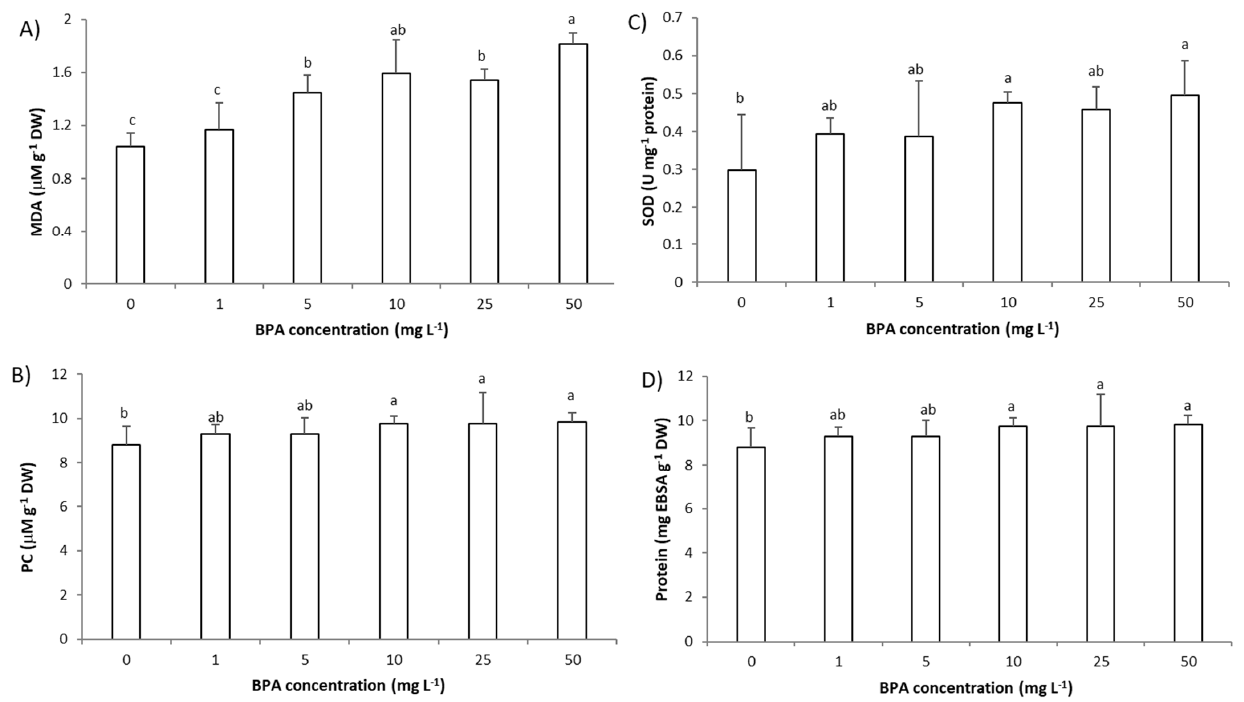
Figure 5. Oxidative stress parameters and level of proteins in Allium cepa root cells exposed to BPA (1–50 mg L − 1 ) for 3 days. Oxidative stress was monitored as level of: ( A ) malondialdehyde (MDA) as marker of lipid peroxidation, ( B ) protein carbonyls (PC) as marker of oxidative damage to proteins, ( C ) catalytical activity of antioxidative enzyme superoxide dismutase (SOD) and ( D ) total proteins. Results are presented as means ± SD (n = 5 replicates). Different letters indicate significant difference ( p ≤ 0.05). 0—control plants, not exposed to BPA.